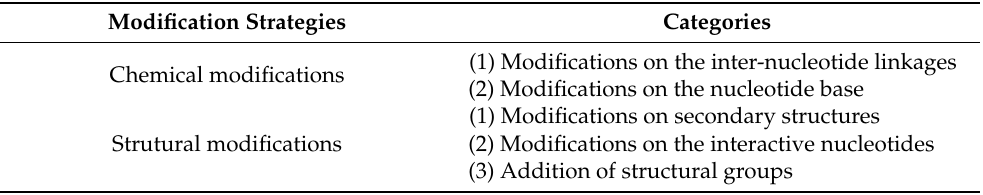
Table 4. Classification of chemical and structural modification